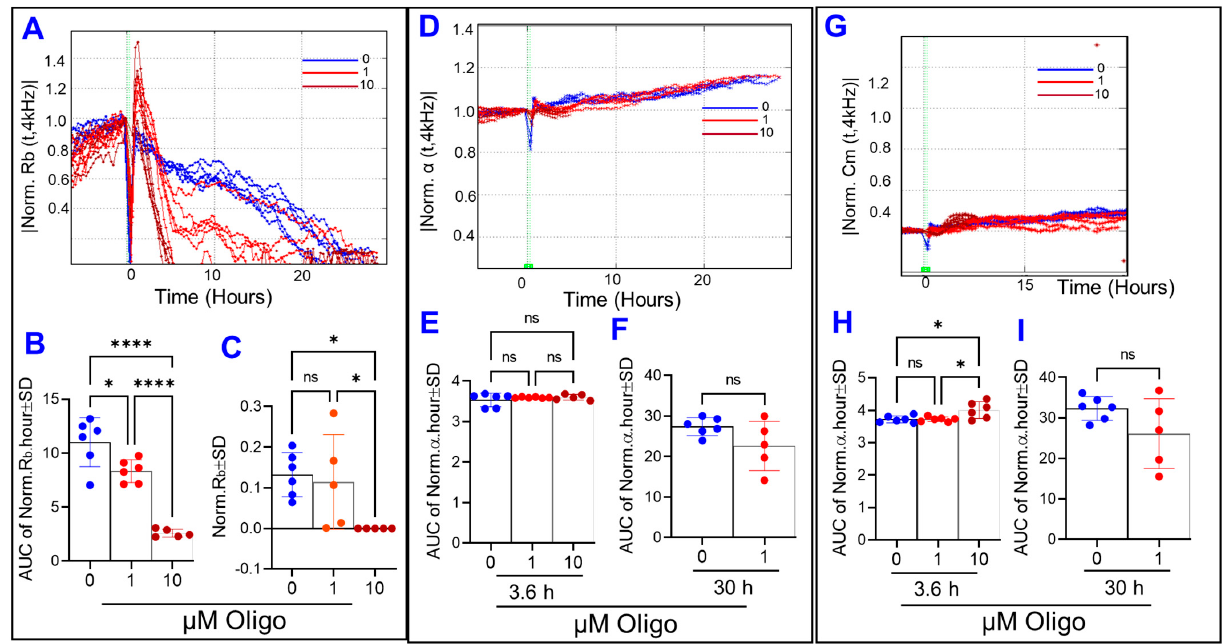
Figure 7. Real-time monitoring of human retinal endothelial cells’ α , R b , and C m treated with an ATP synthase inhibitor (Oligomycin; Oligo). ( A ) Normalized R b curve measured at 4000 Hz vs. time (t). ( B ) AUC of normalized R b measured between 0 and 30 h. ( C ) The bar graph represents normalized R b measured at t = 30 h. ( D ) Normalized α curve measured at 4000 Hz vs. time (t). ( E ) and ( F ) AUC of normalized α measured between (0–3.6 h) and (0–30 h), respectively. ( G ) Normalized C m curve measured at 4000 Hz vs. time (t). ( H , I ) AUC of normalized C m measured between (0–3.6 h) and (0– 30 h), respectively. Data were analyzed by the ANOVA test followed by the Tukey post hoc test. Abbreviations: Norm, normalized; AUC, area under the curve; ns, no significance; * p , ≤ 0.05; **** p , ≤ 0.0001; n = 5–6/group.